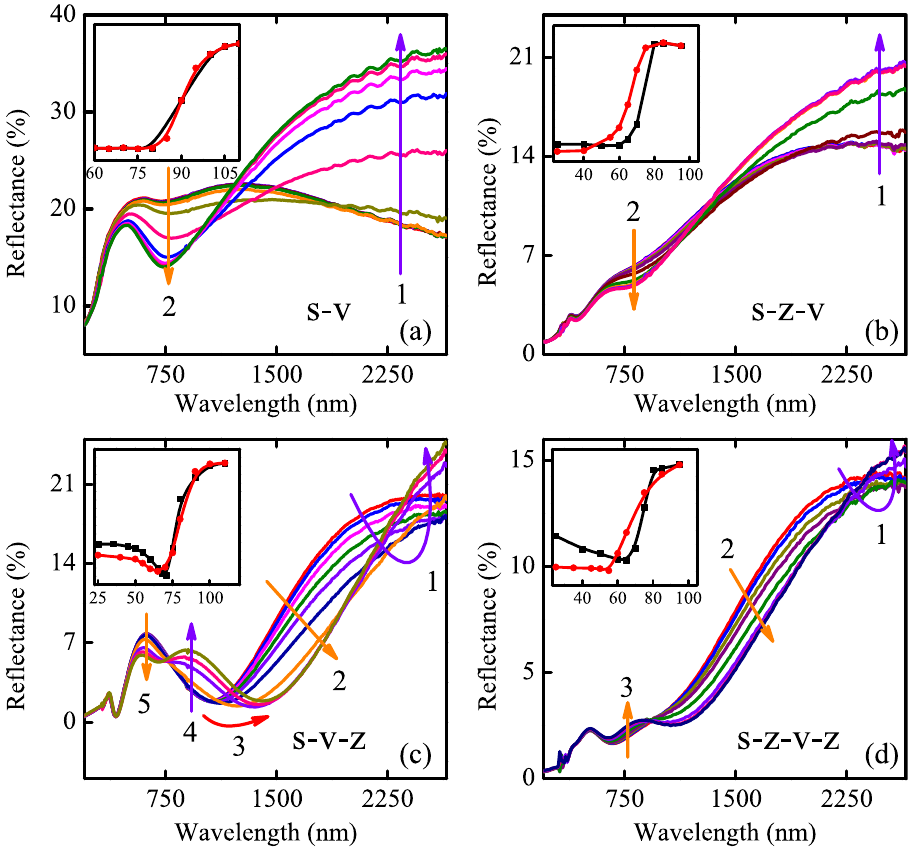
Figure 3. ( a – d ) The temperature dependent reflectance spectra for the four structures. The inset shows the variation of the reflectance with temperature at 2650 nm.